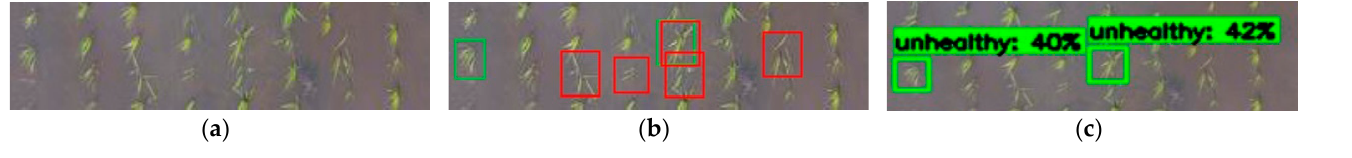
Figure 10. Showing an example of true positive, false positive and false negative. Red bounding boxes represent the annotation of labelled bounding boxes while the green boxes are the predicted boxes of the model. Boxes with color overlapping in ( b ) are the correctly detected defective paddy seedlings or true positive, the non-overlapping red boxes is the false negative or misdetection and the non-overlapping green boxes are false positive, or healthy paddy seedlings detected as unhealthy or defective.( a ) Input Image, ( b ) Ground Truth, ( c ) Output Images.